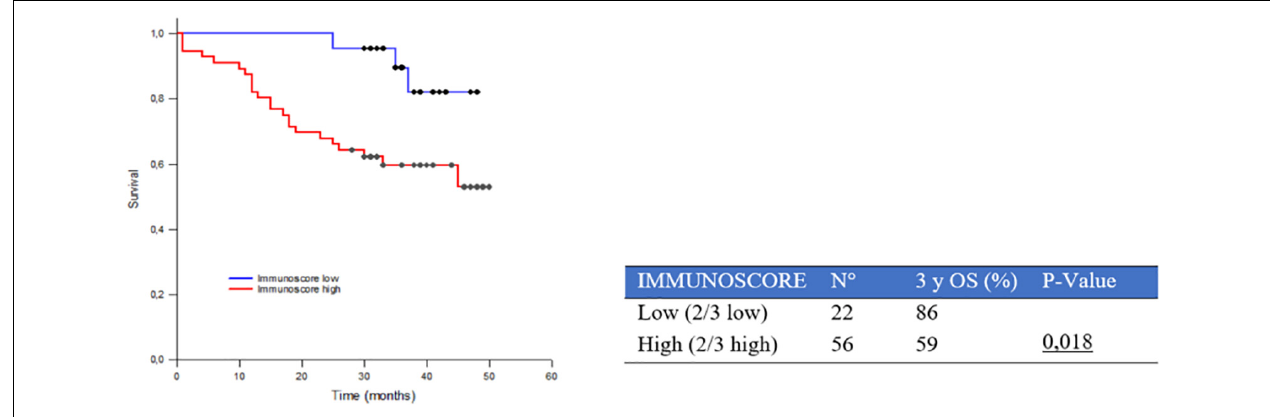
FIGURE 5 | Three-year survival rate (3yOS) data and curves according to low and high combined peritumoral (PT) immunoscore. The immunoscore is given by the combination of different peritumoral inflammatory components (PT CD8+, PT CD4+, and PT CD68+).